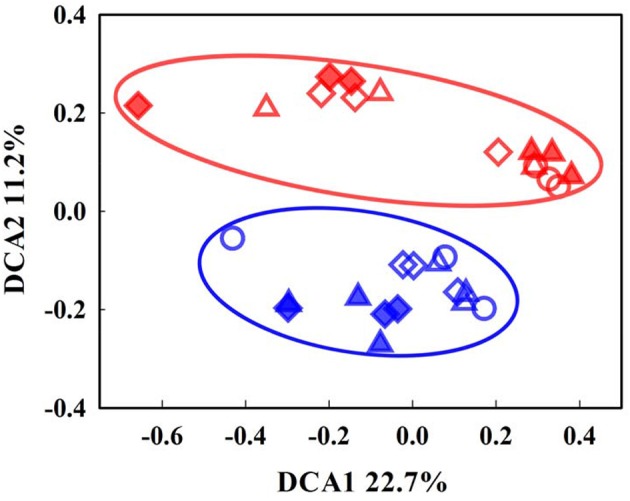
Detrended correspondence analysis (DCA) of microbial community patterns between the organic- and mineral-rich soils. The data include both pre-incubation and incubated samples at −2 and 8°C. Open circles, triangles, and diamonds represent samples incubated at −2°C for 0, 34, and 122 days, respectively. Solid triangles and diamonds represent samples incubated at 8°C for 60 and 122 days. Organic-rich samples are marked red and mineral soils marked blue.